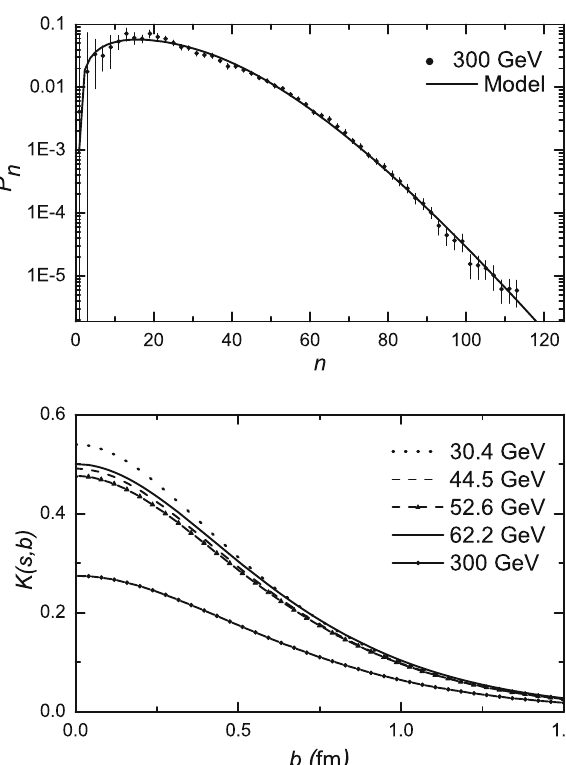
Fig. 4 Same as Fig. 1 but at 62.2 GeV